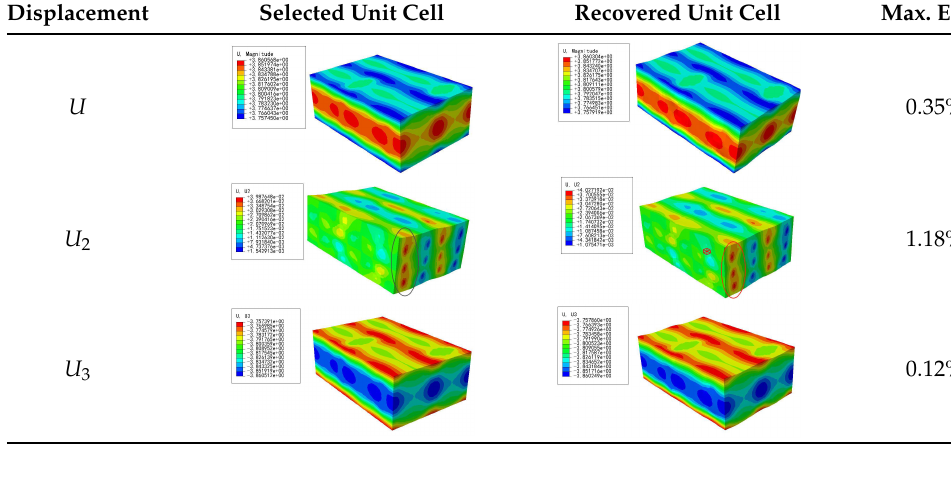
Table 5. Comparison of local displacement field within the unit cell under the conditions in Case 2 (unit: mm).